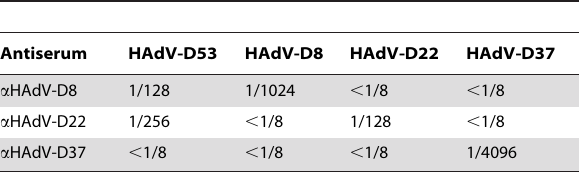
Table 4. Neutralization of HAdV-D53 with hyper immune